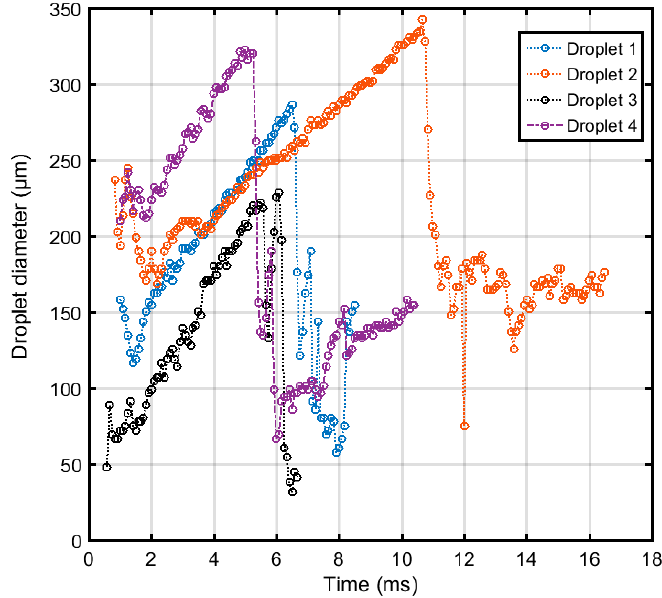
Figure 6. Effect of different droplet size on time to puffing of 10% water content sprayed at 1000 bar injection pressure.